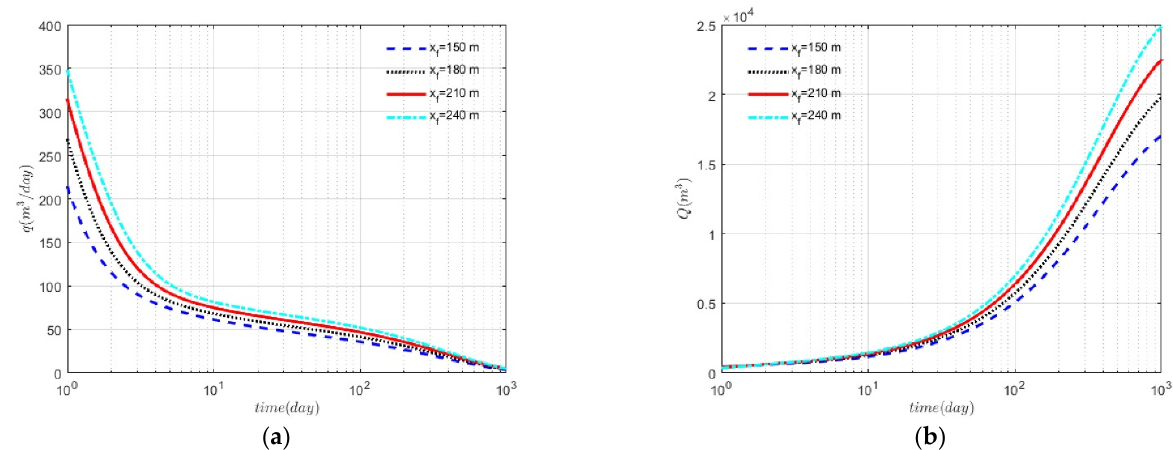
Figure 7. The effect of fracture half-length on productivity: ( a ) effect of fracture half-length on well production rate; ( b ) effect of fracture half-length on cumulative production rate.